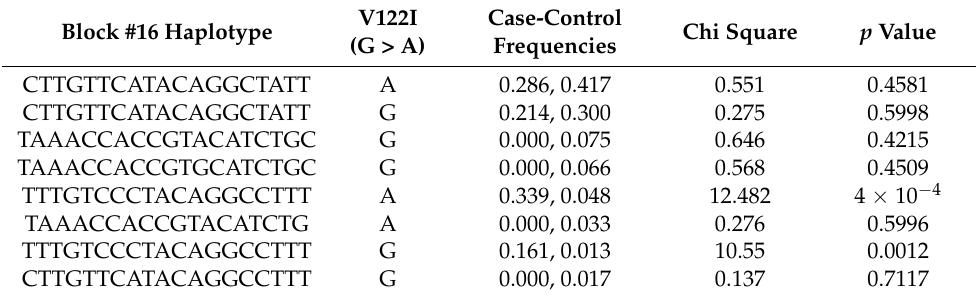
Table 3. Associations with “having 10 or more outpatient surgeries” considering the haplotypic phase of non-coding regulatory haplotype (linkage disequilibrium (LD) Block #16) and Val122Ile mutation in the carriers-only sample ( n =